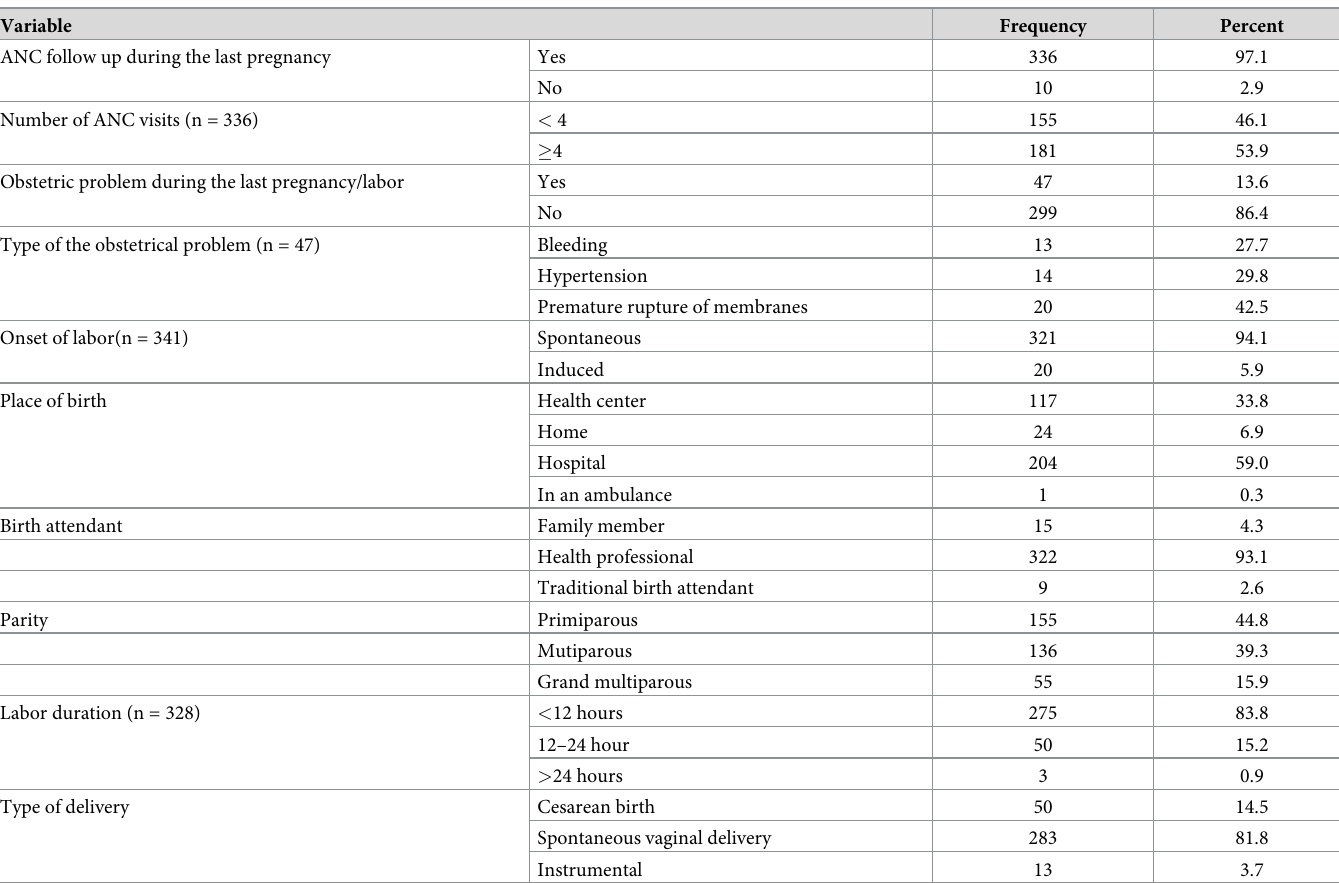
Table 2. Obstetrics characteristics of the mothers of the neonates admitted to Arba Minch and Jinka General Hospital NICUs, Southwest Ethiopia, 2017 (n = 346). Variable